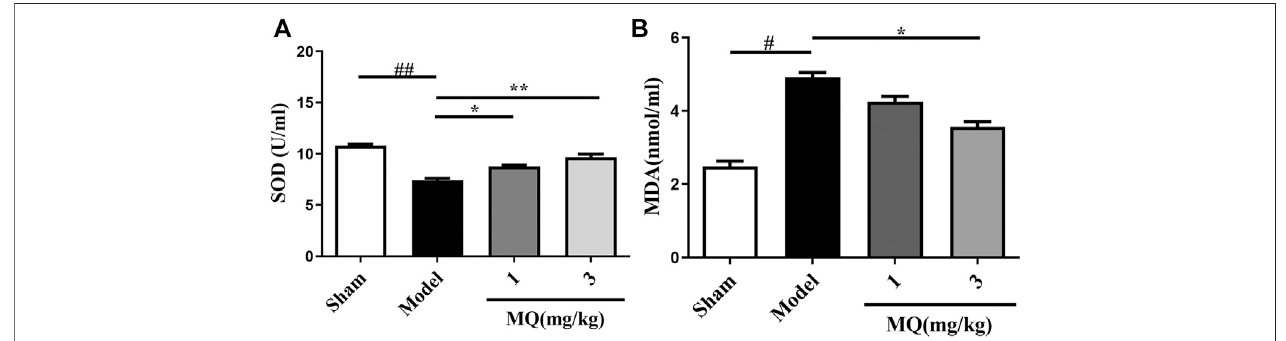
FIGURE4| EffectsofMQonthelevelsofSODandMDAinMCAOrats. (A) TheactivityofSODafterI/Rindifferentgroups, (B) thelevelsofMDAafterI/Rindifferent groups. ** p < 0.01, Model group vs. 3 mg/kg group; ** p < 0.01, Model group vs. 3 mg/kg group; * p < 0.05, Model group vs. 1 mg/kg group, n (cid:2) 3.